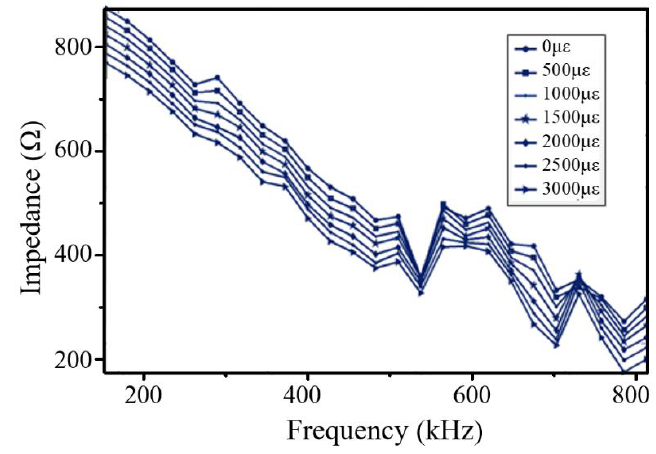
Figure 15. The impedance of PZT under different strain conditions at the adhesive.